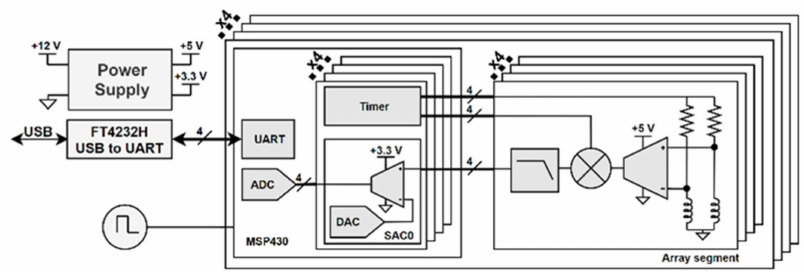
Figure 5. Array probe block diagram.